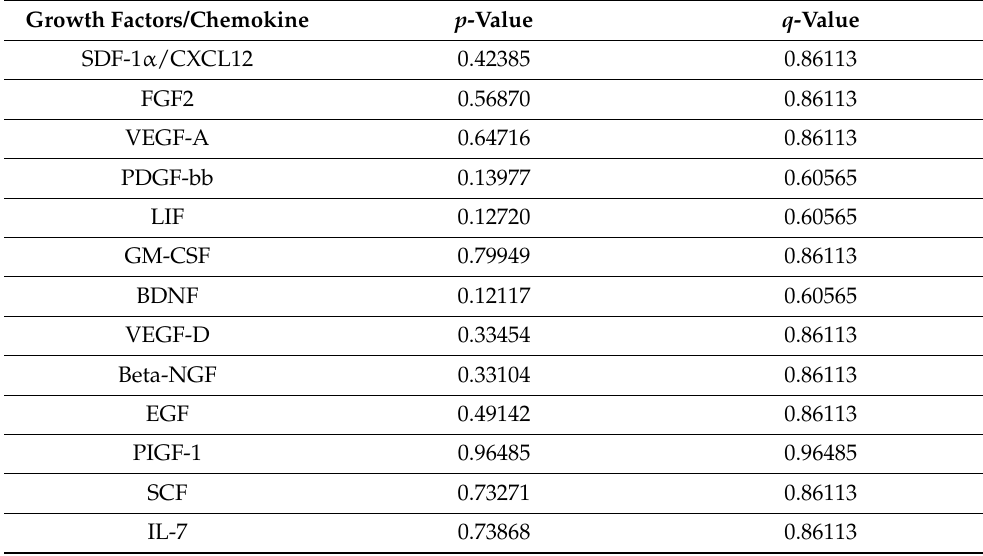
Table 5. Log transformed data analysis of all growth factors/chemokines in liver